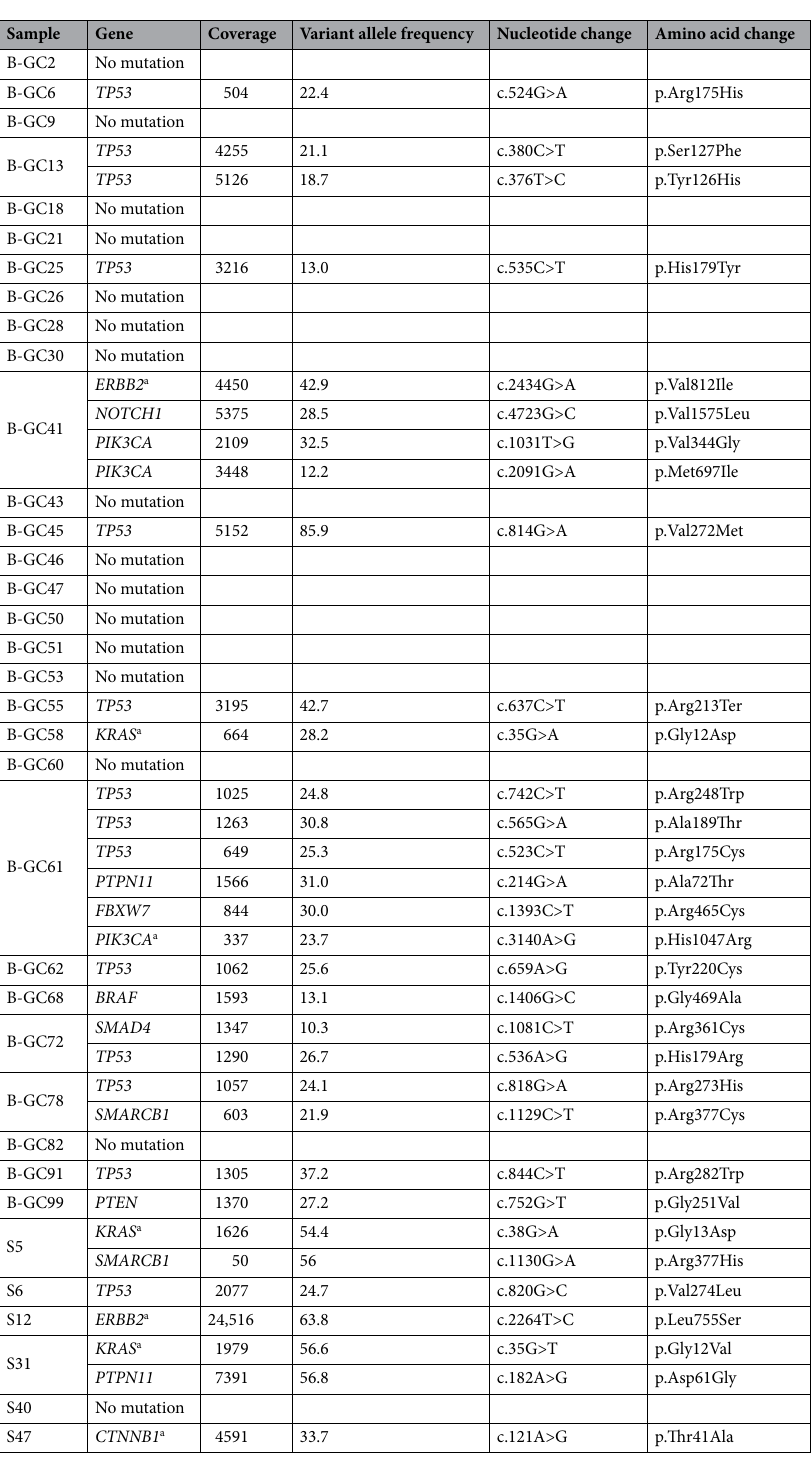
Table 2. List of somatic mutations in the 35 gastric cancers with past H. pylori infection. a Activated oncogene